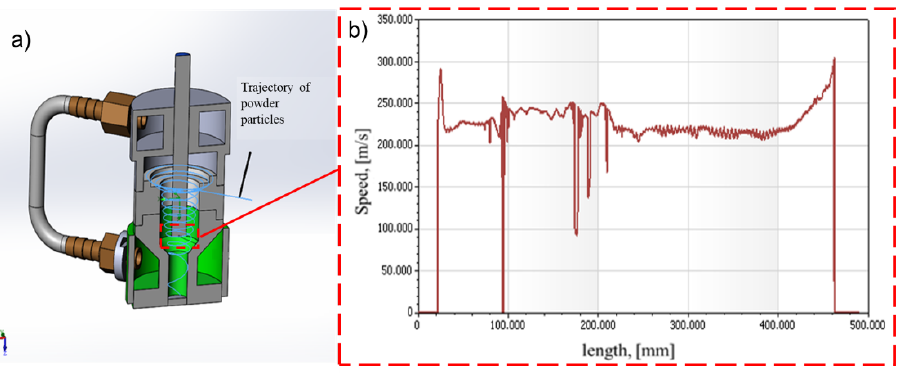
Figure 4. Powder particle velocity results: ( a ) powder particle trajectory; ( b ) titanium nitride particle velocity in the plasmatron.